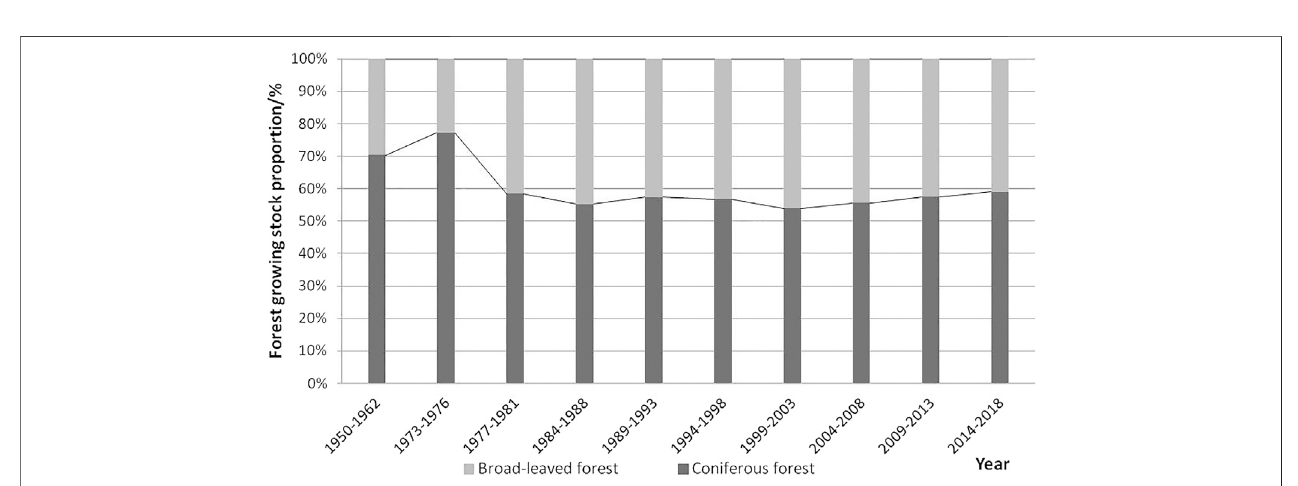
FIGURE 7 | Forest growing stock proportion of broad-leaved forest and coniferous forest.